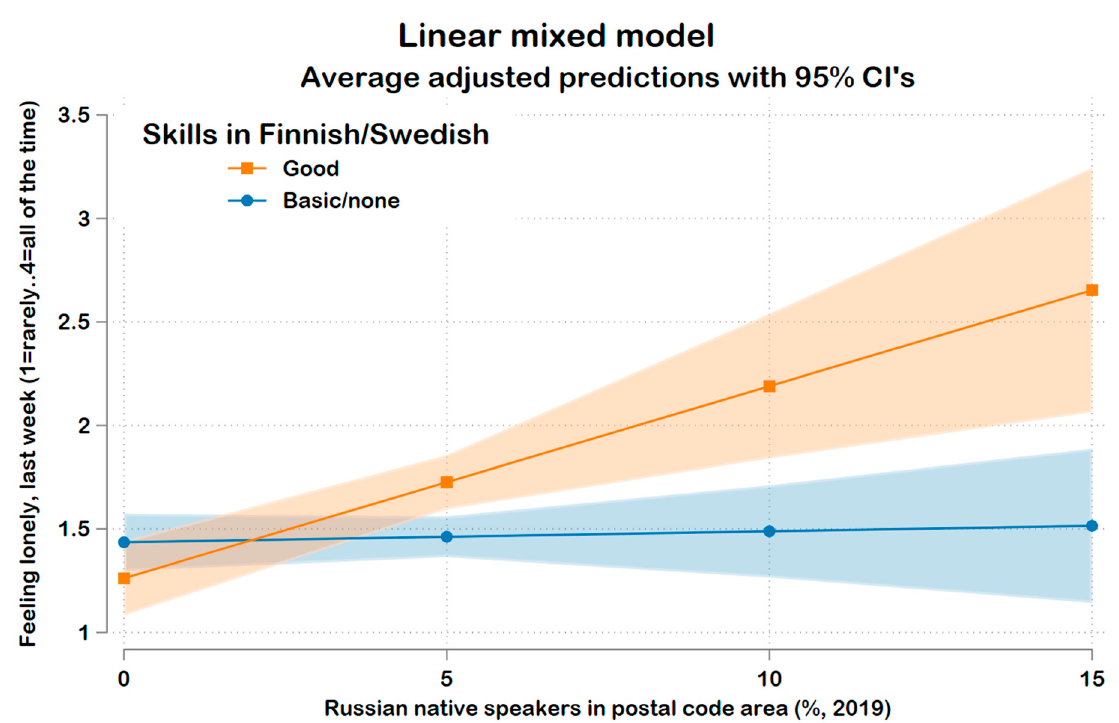
Figure 1. The association between Russian-speaker density and loneliness is moderated by local language skills ( p < 0.0005).